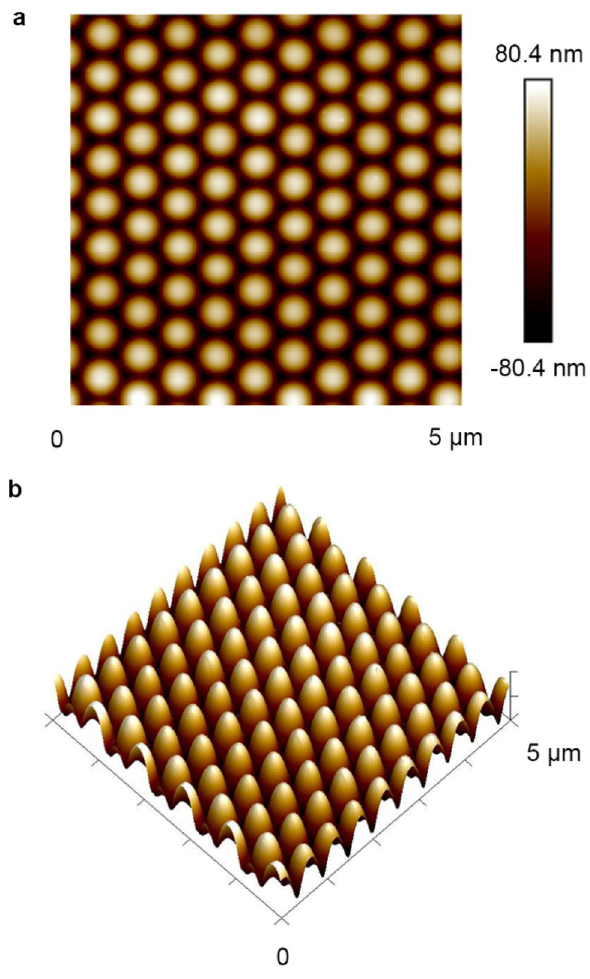
Figure 7. Typical AFM images of the IA-Chol submicron pillar arrays after irradiation with the right-hand circularly polarized light for 60 min. ( a ) Top-view AFM image of the array. ( b ) 3D image corresponding to panel ( a ). The light intensity was 300 mW cm −2